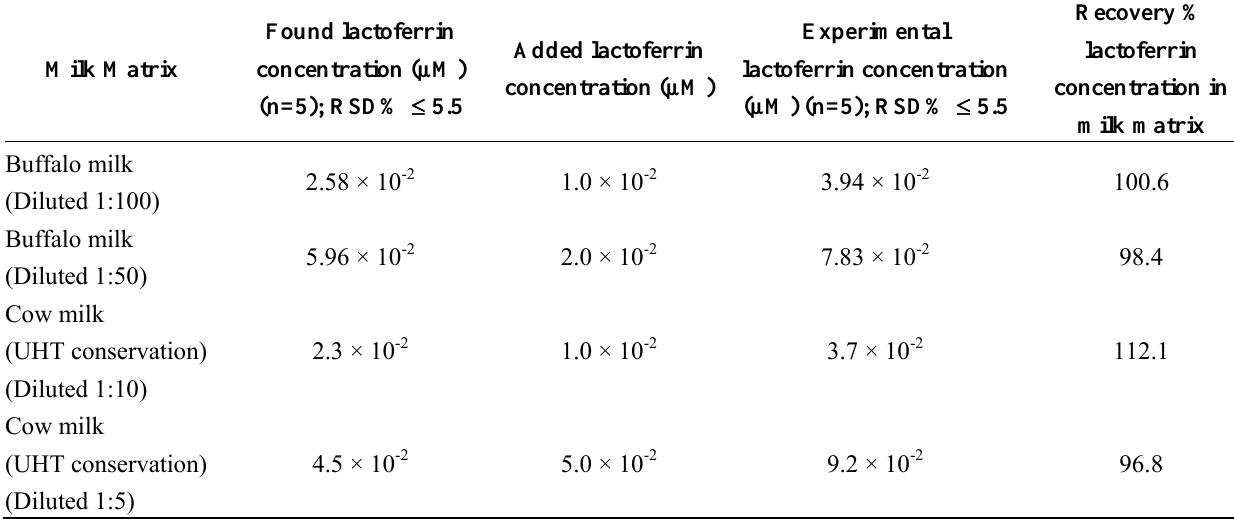
Table 3. Recovery tests of added lactoferrin in milk and in several dairy milk products using the standard addition